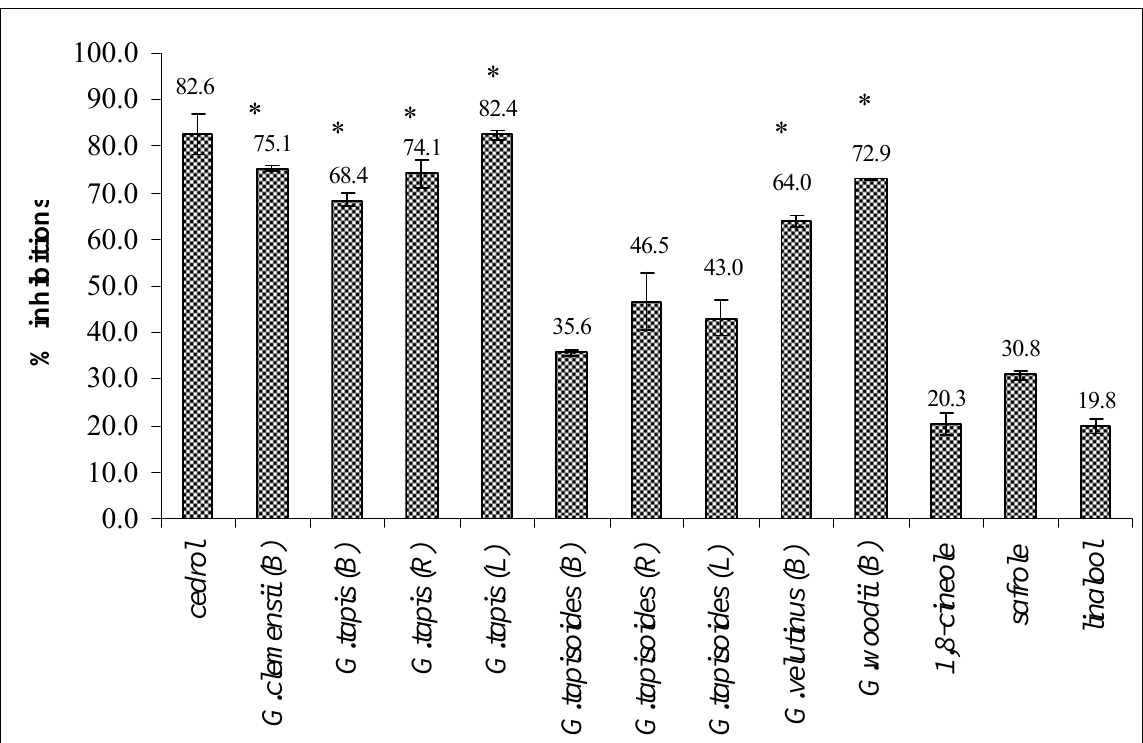
Figure 1. Inhibitory effects the leaf (L), bark (B) and root (R) oils of Goniothalamus and standards (18.2 µg/mL) on 3 H-PAF binding to PAF receptor on rabbit platelets. Cedrol was used as a positive control. Each point represents the mean of three experiments, each in triplicate. Standard deviation of the mean are indicated as vertical bars. *p < 0.05 as compared with the respective control.